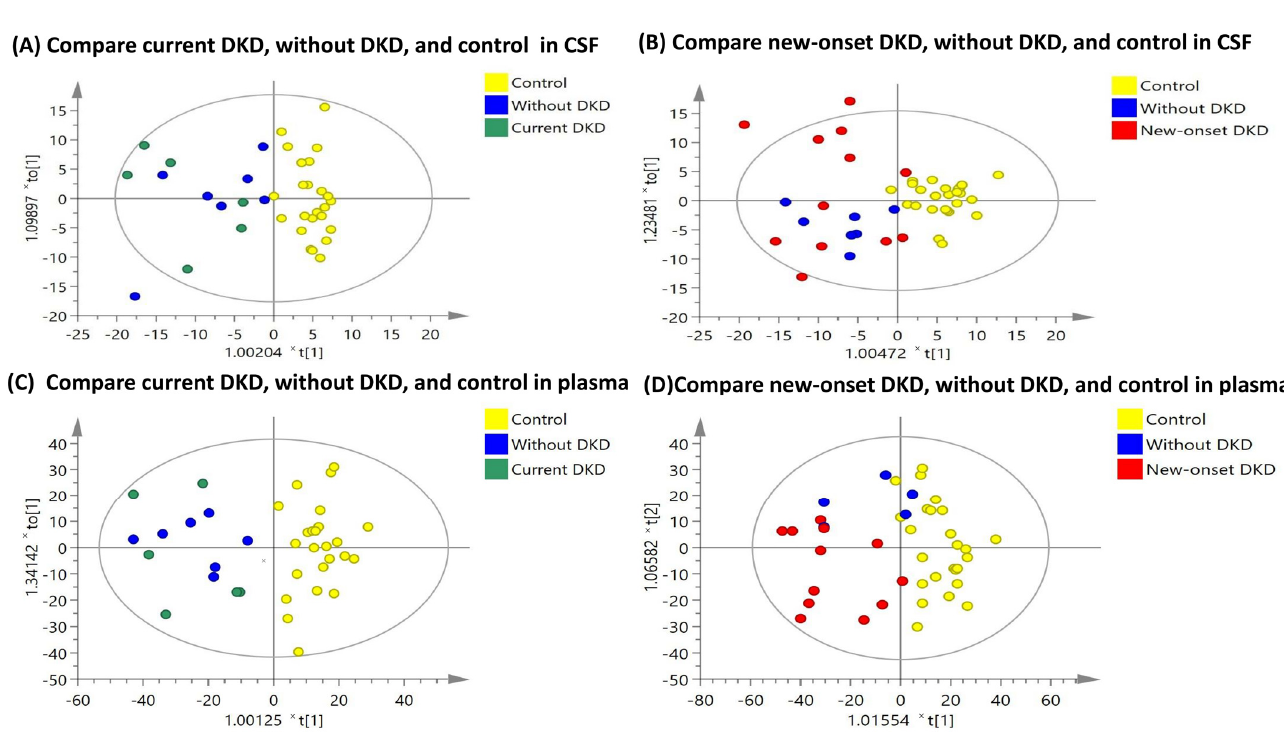
Figure 2. Orthogonal partial least-squares discriminant analysis (OPLS-DA) score plots in ( A ) CSF samples for the comparison among the diabetic patients with current DKD, diabetic patients without DKD, and the control participants (reliability: R 2 X = 0.516, R 2 Y = 0.450, Q 2 = 0.275); ( B ) CSF samples for the comparison among diabetic patients with new-onset DKD, diabetic patients without DKD, and the control participants (reliability: R 2 X = 0.428, R 2 Y = 0.461, Q 2 = 0.311); ( C ) plasma samples for the comparison among the diabetic patients with current DKD, the diabetic patients without DKD, and the control participants (reliability: R 2 X = 0.550, R 2 Y = 0.498, Q 2 = 0.304); ( D ) plasma samples for the comparison among the diabetic patients with new-onset DKD, the diabetic patients without DKD, and the control participants (reliability: R 2 X = 0.530, R 2 Y = 0.514, Q 2 = 0.413). Table 2. Altered metabolites in the CSF samples of the type 2 diabetic patients with DKD, compared to patients without DKD or the control